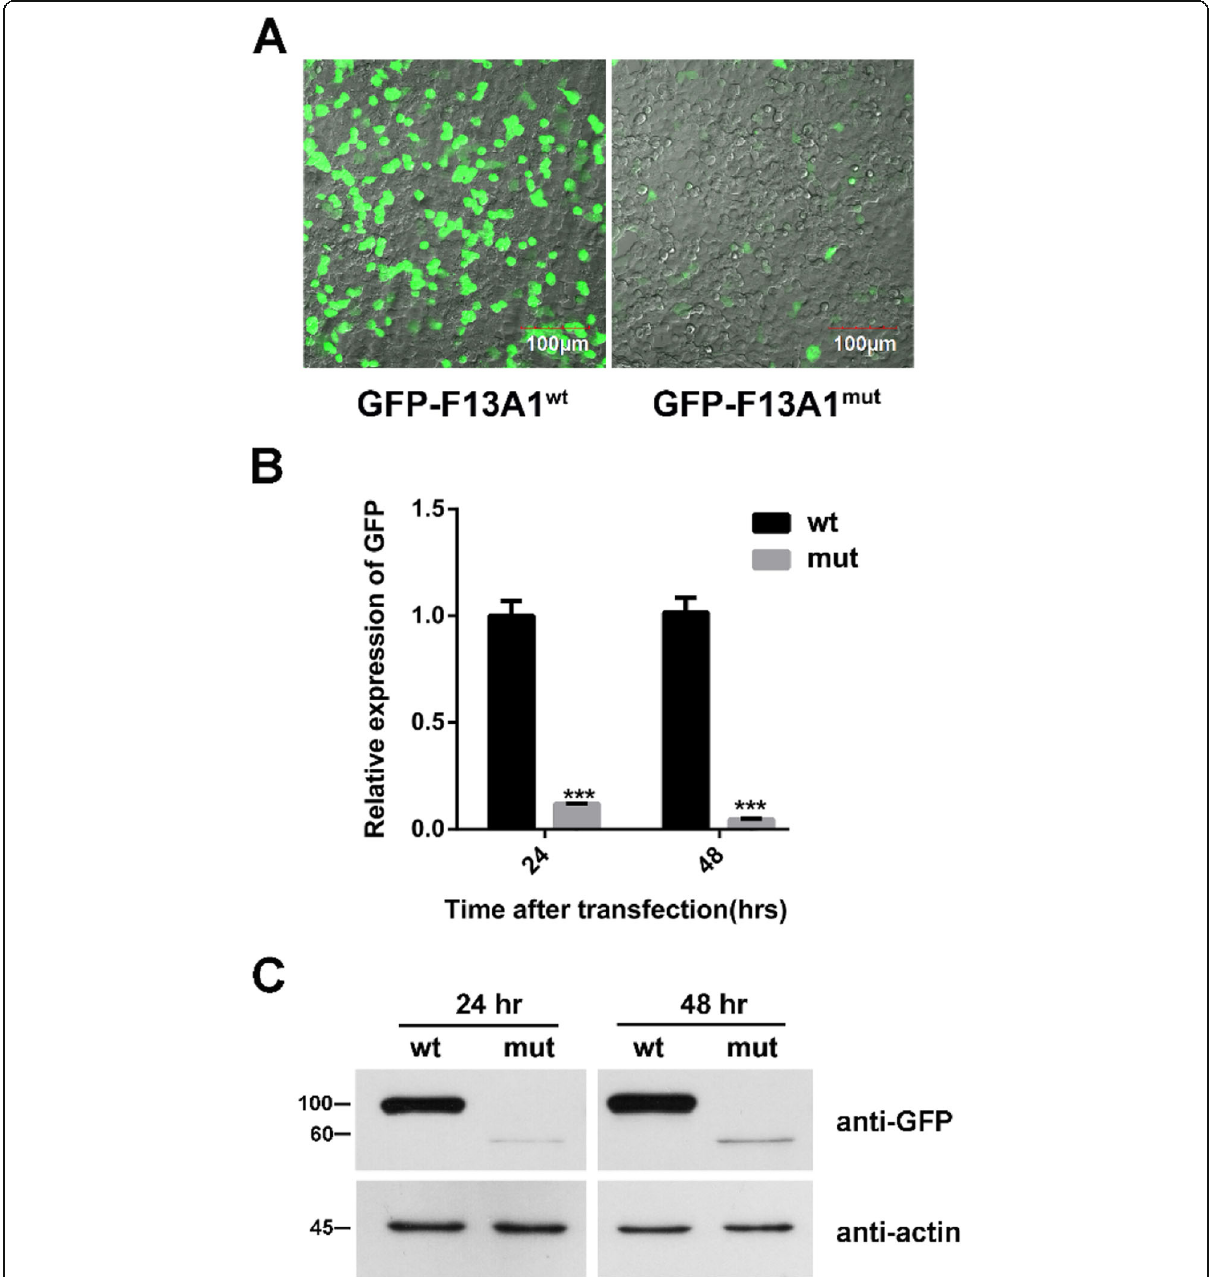
Fig. 4 GFP-F13A1 expression in transfected cells. A , 293 T cells were transfected with wt and mut plasmids for 48 h. Fluorescent signals of GFP- F13A1 were detected via fluorescent microscopy. 293 T cells were transfected with wt and mut plasmids. B,C , GFP-F13A1 mRNA and protein expression were quantified via qPCR and western blot*** p <